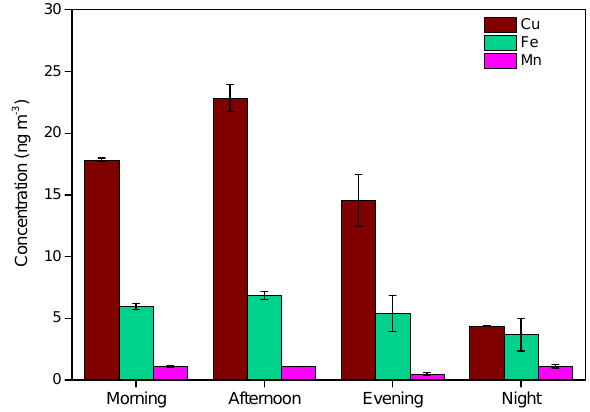
Figure 5. Diurnal trend in the ambient concentrations of carbona- ceous aerosols, i.e., EC, OC, and WSOC, and the ratio of OC / EC and WSOC / EC, as measured from the time-segregated integrated filters. Error bars denote standard deviation (1 σ) of the triplicate measurements.